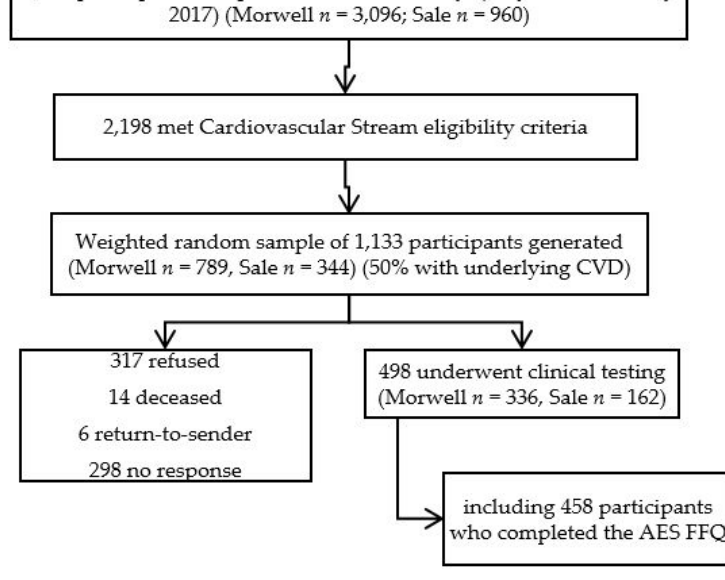
Figure 1. Flow diagram of participant recruitment. CVD = cardiovascular disease, AES = Australian Eating Survey, FFQ = food frequency